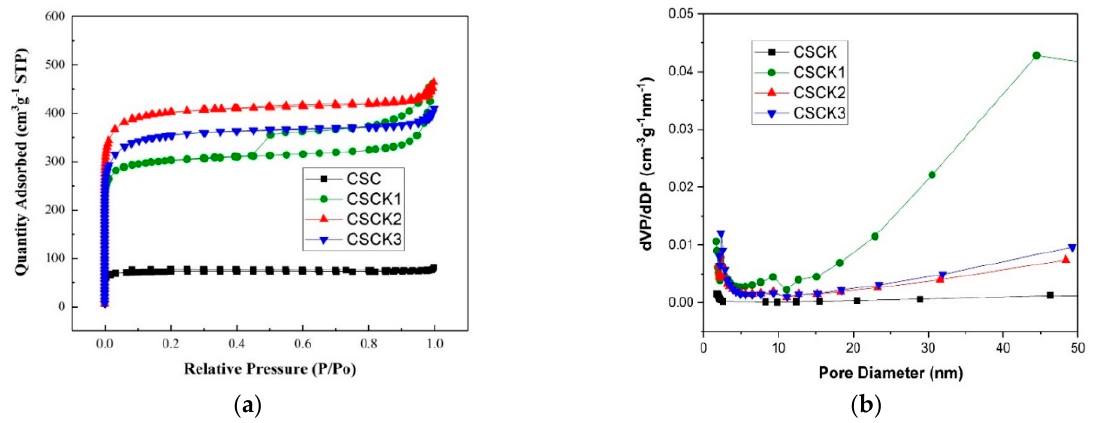
Figure 2. ( a ) N 2 physisorption curves; and ( b ) pore size distribution of CSC and CSCKs.